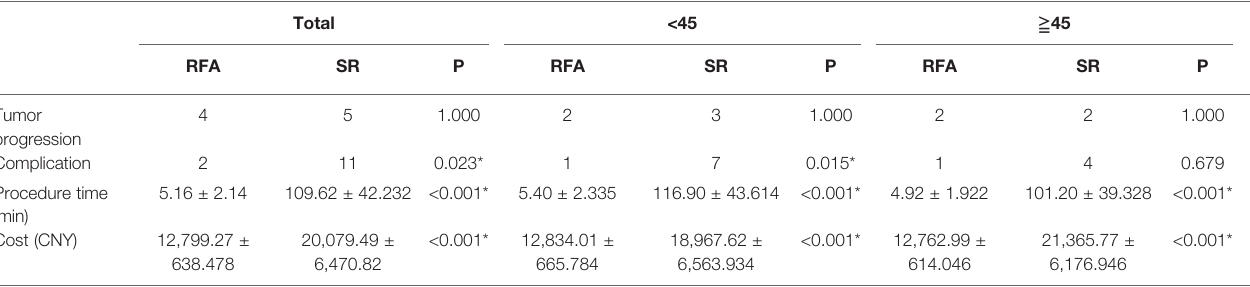
TABLE 5 | Comparative analysis of treatment outcomes between the age